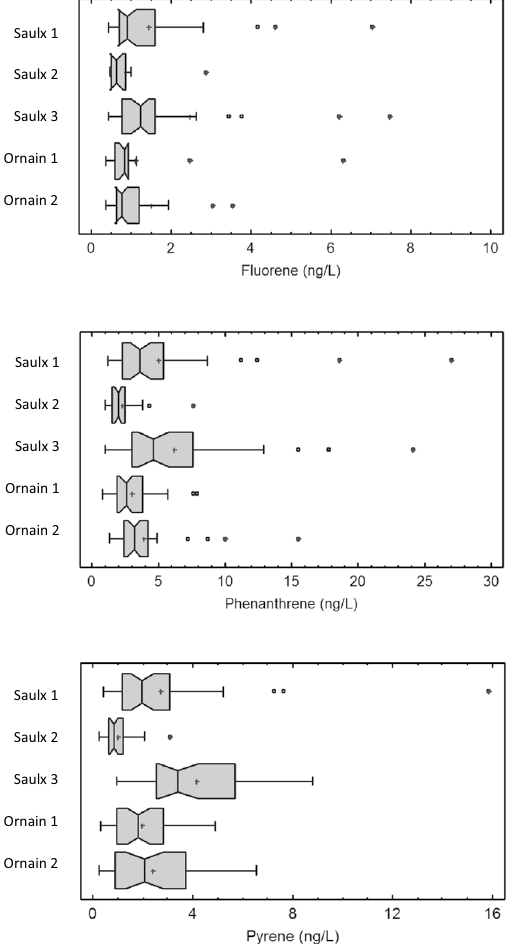
respectively represented by a horizontal line and a red + sign inside the box. The box notch corresponds to the error associated with the